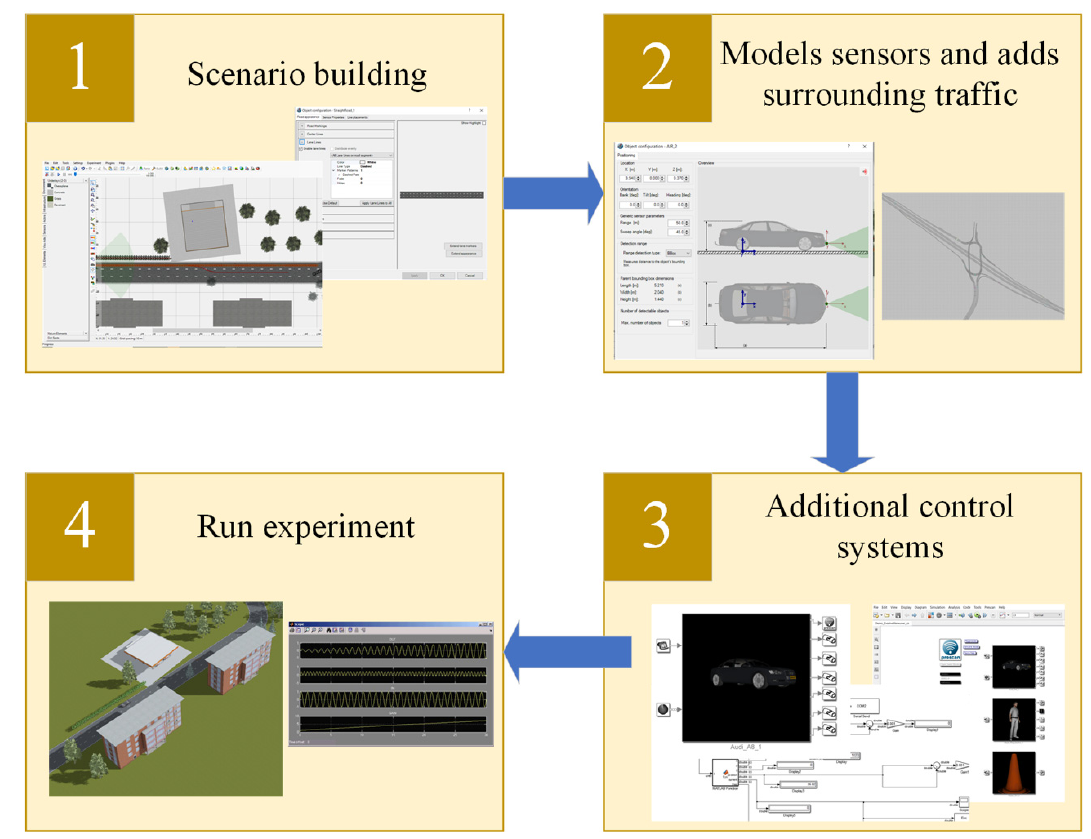
Figure 5. Developing stages of integrated simulation platform.